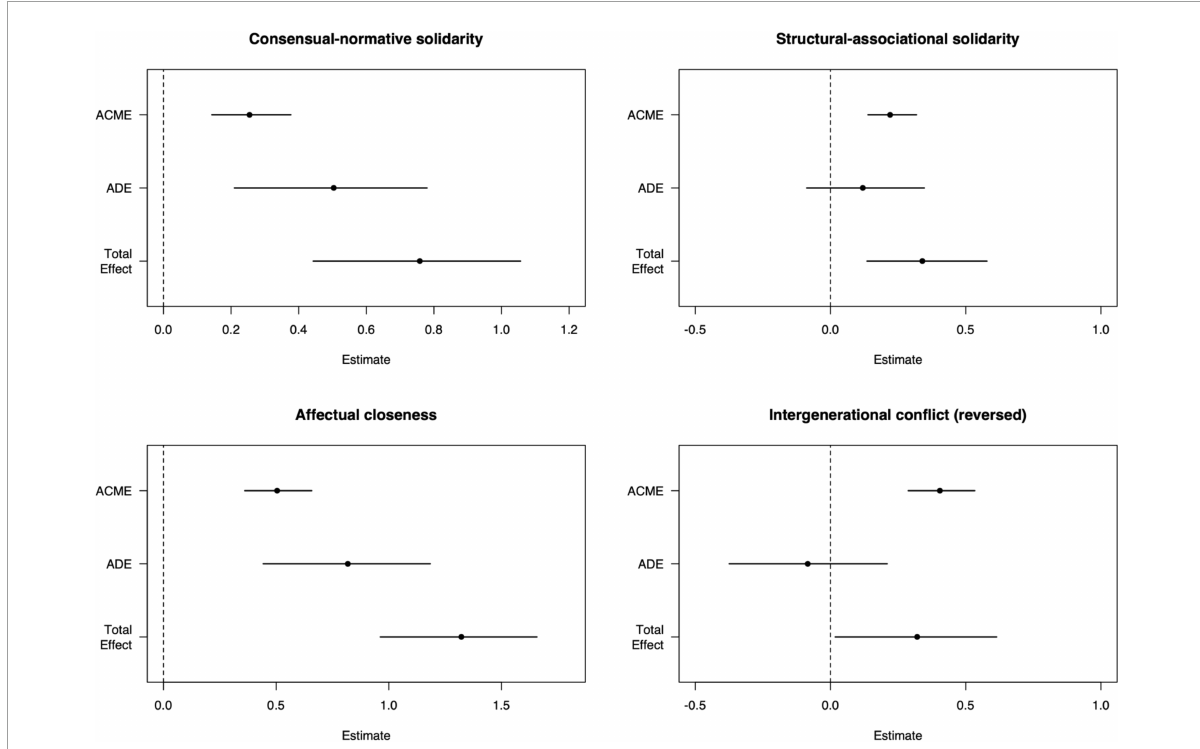
FIGURE1 Results of the mediation analyses. Error bar shows 95% quasi-Bayesian confidence intervals. ACME, average mediation effect; ADE, average direct